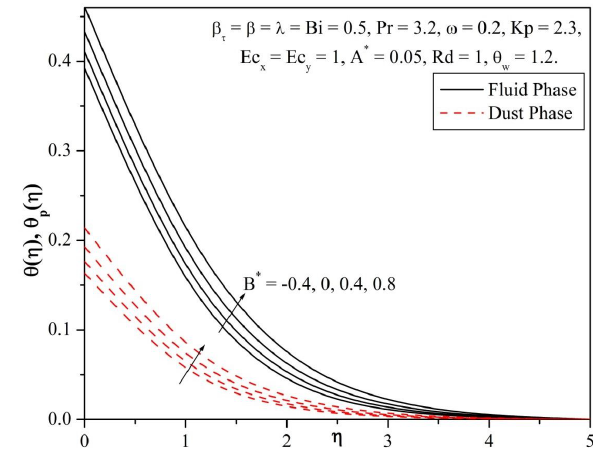
Fig. 8: Dimensionless profiles of u , u p velocity components for different values of β .